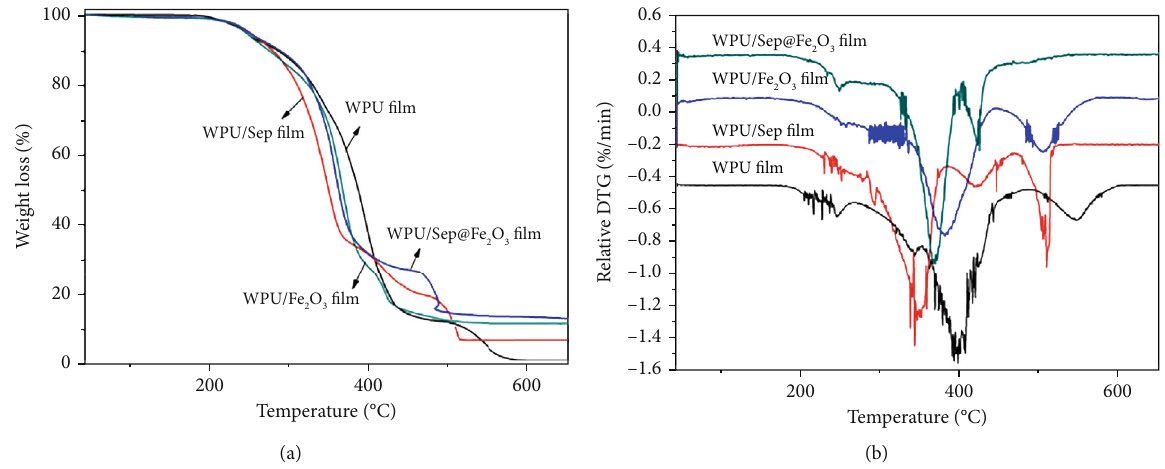
O (a) from Figure 4(b) and (b) from Figure 4(e), analyzed by 2 3